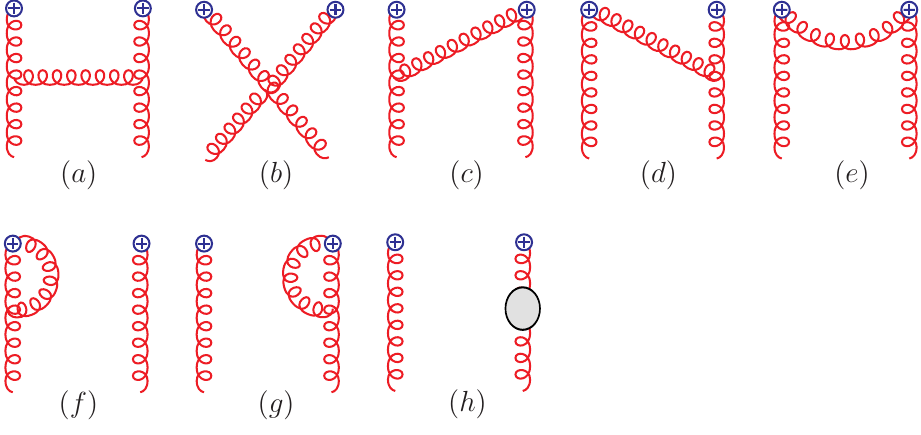
Figure 2 . One-loop Feynman diagrams for the gluon TMDPDFs without gauge link interactions.